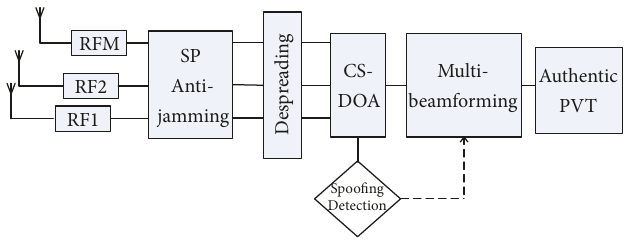
Figure 2: GPS receiver antijamming and antispoofing